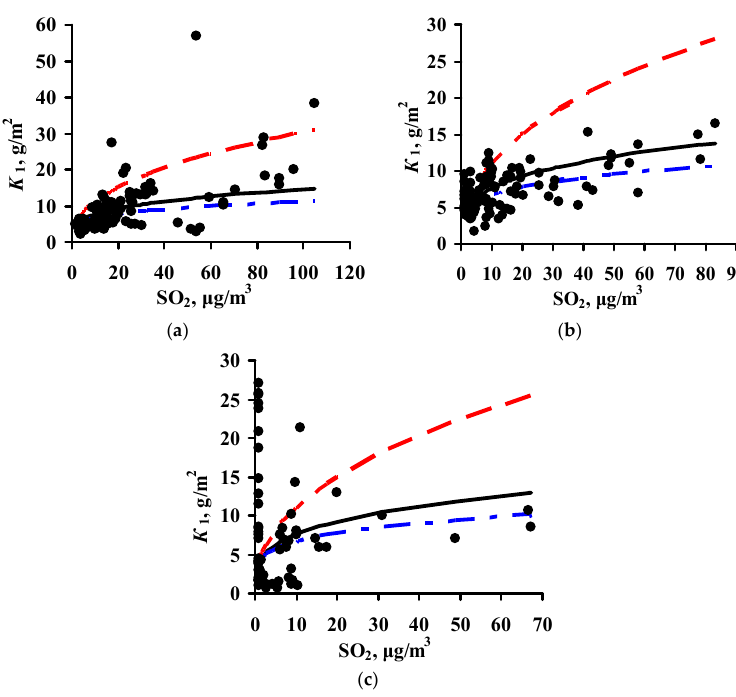
Figure 2. Dependence of first-year corrosion losses of zinc ( K 1 ) on SO 2 concentration based on the data from ISO CORRAG program ( а ), UN/ECE program ( b ), and MICAT project ( с ). ▬▬ — α = 0.28 (New DRF), ▬ ▬ — α = 0.44 (Standard DRF), ▬ ● ▬ — α = 0.22 (Unified DRF).